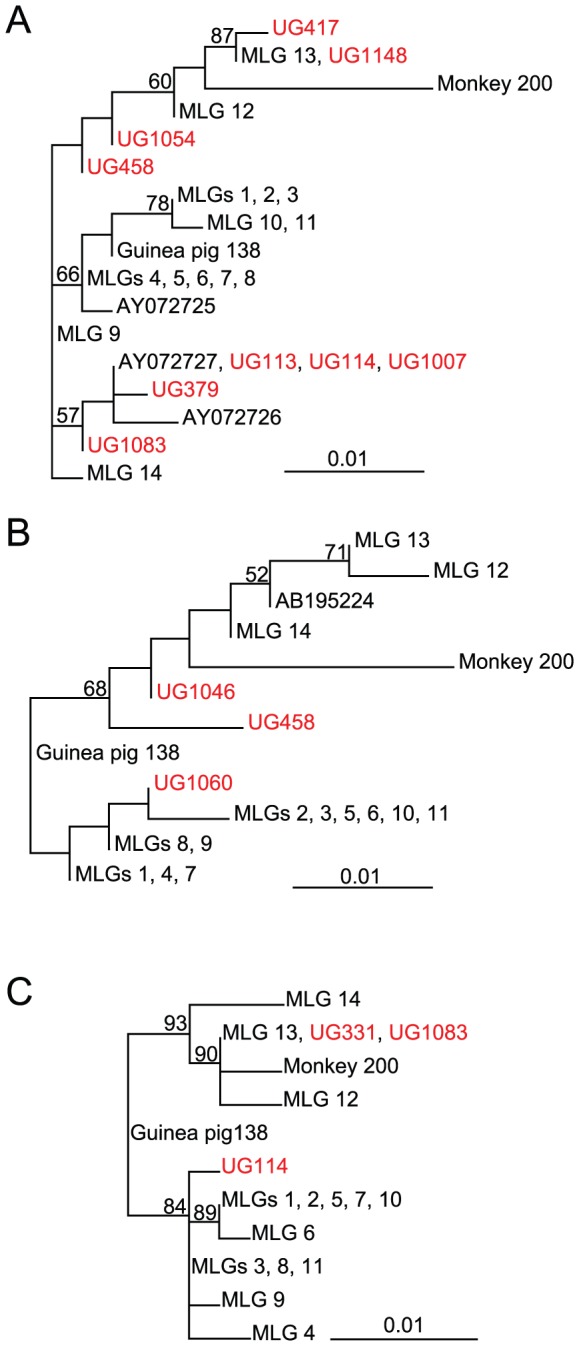
Nucleotide maximum likelihood trees based on bg, gdh, and tpi gene sequences from assemblage B isolates.Unambiguous sequences identified in this study were combined with isolates from our previous studies [13], [16]. Phylogenetic trees of (A) bg, (B) gdh, and (C) tpi gene sequences. Sequences from this study are indicated in red. Only bootstrap support values >50% are shown.